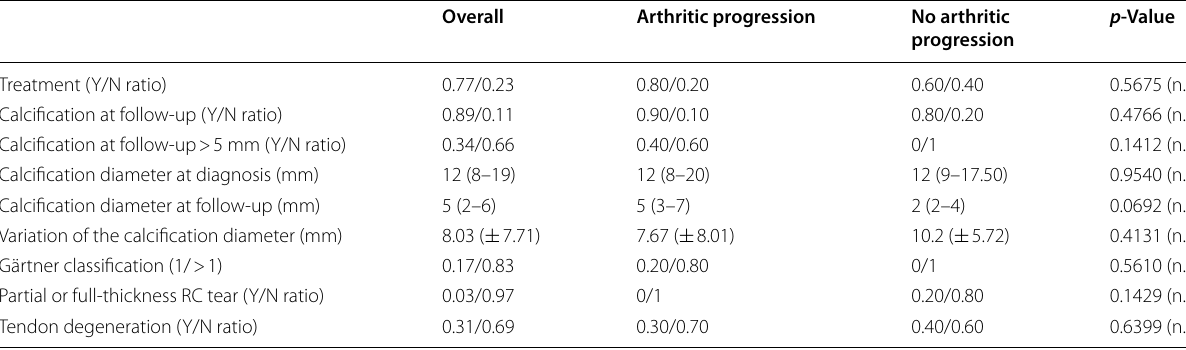
Data are reported as mean (